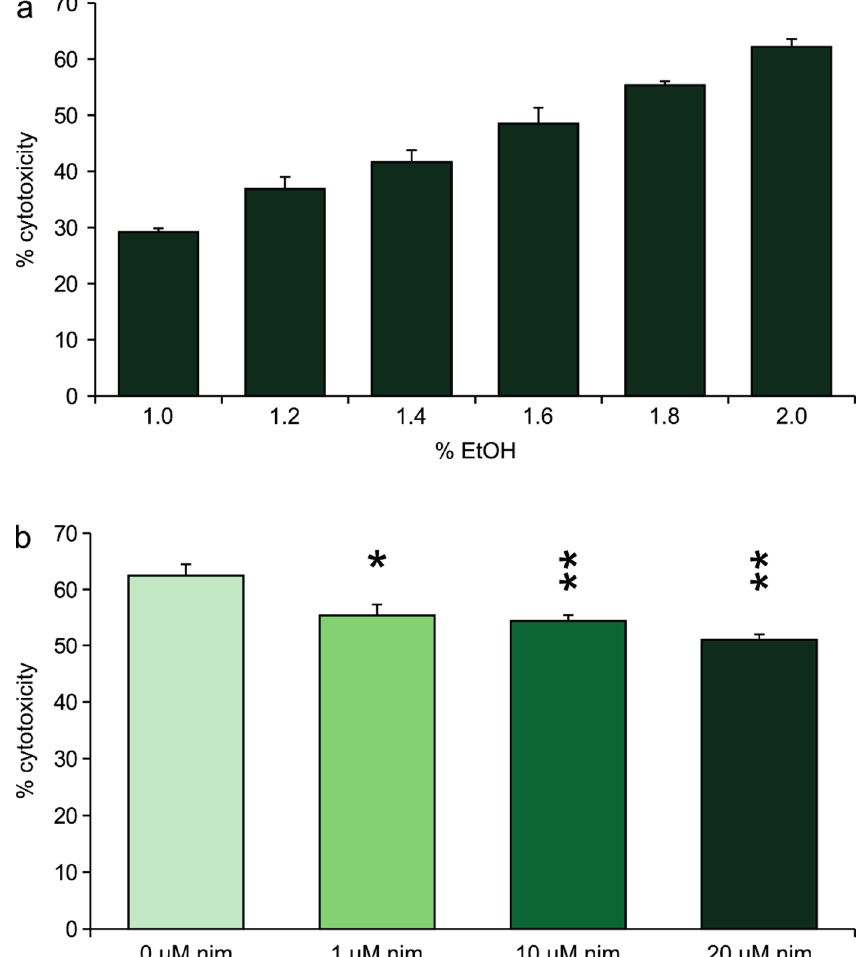
Figure 1. ( a ) Ratio of cytotoxicity induced by increasing ethanol concentrations. Values are given as the mean ± SD (error bars) of one representative out of at least three biologically independent experiments; and ( b ) LDH measurement after ethanol stress. Values are given as the mean ± SD. Nim: nimodipine; single asterisk: p ≤ 0.05 compared to non-treated cells; double asterisk: p ≤ 0.005 compared to non-treated